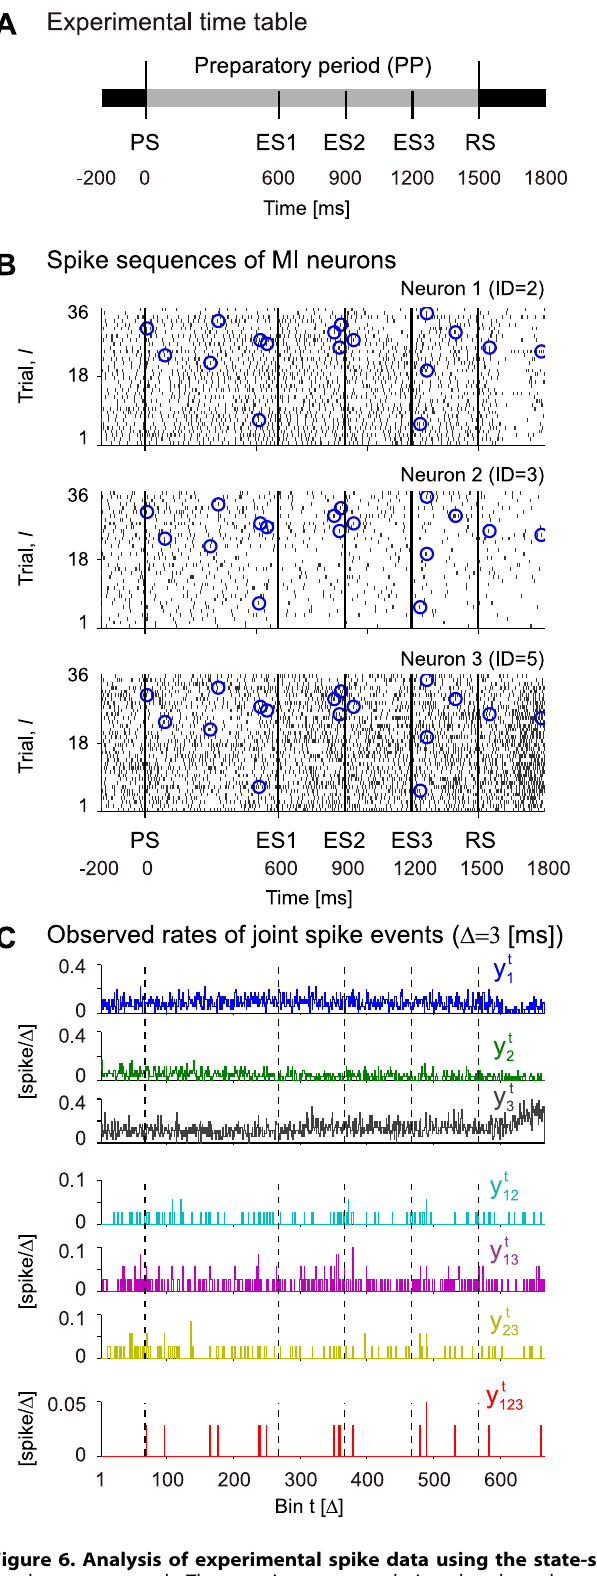
PLoS Computational Biology |